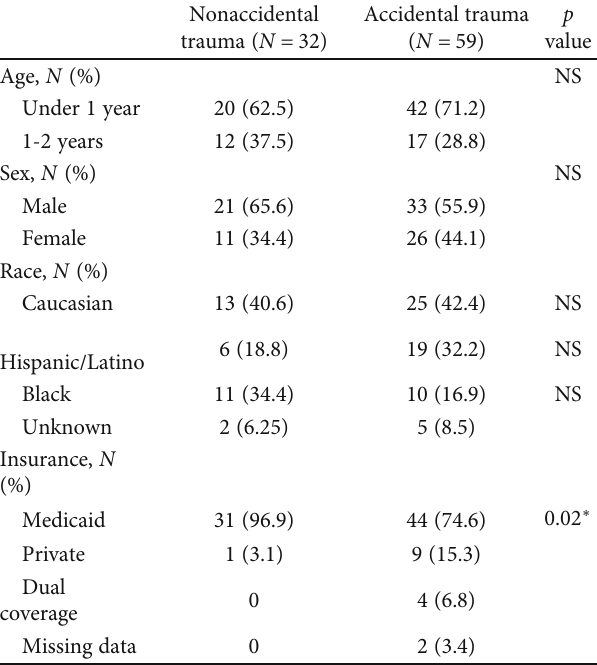
Table 1: Comparison of nonaccidental and accidental trauma by demographic